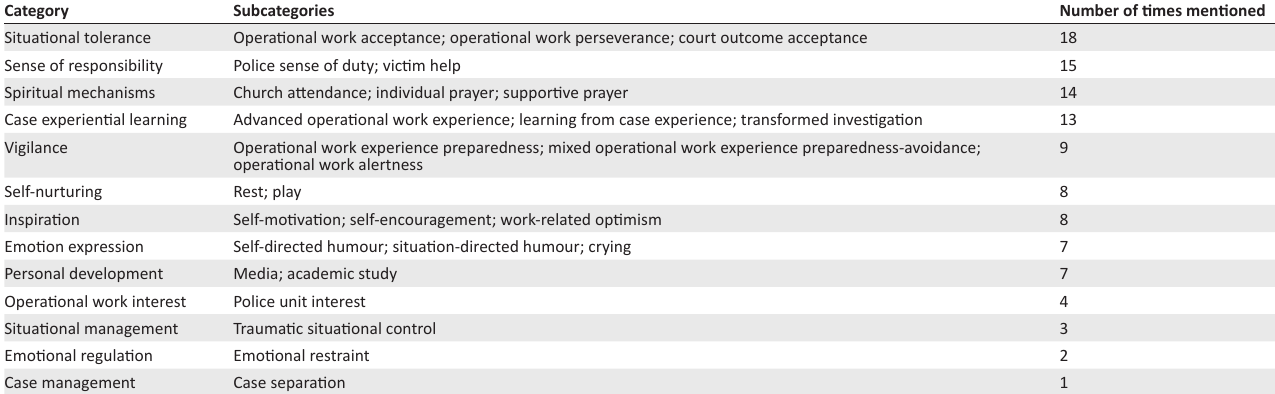
TABLE 1: Contingency table of inner strategies of coping with operational work amongst South African Police Service officers.